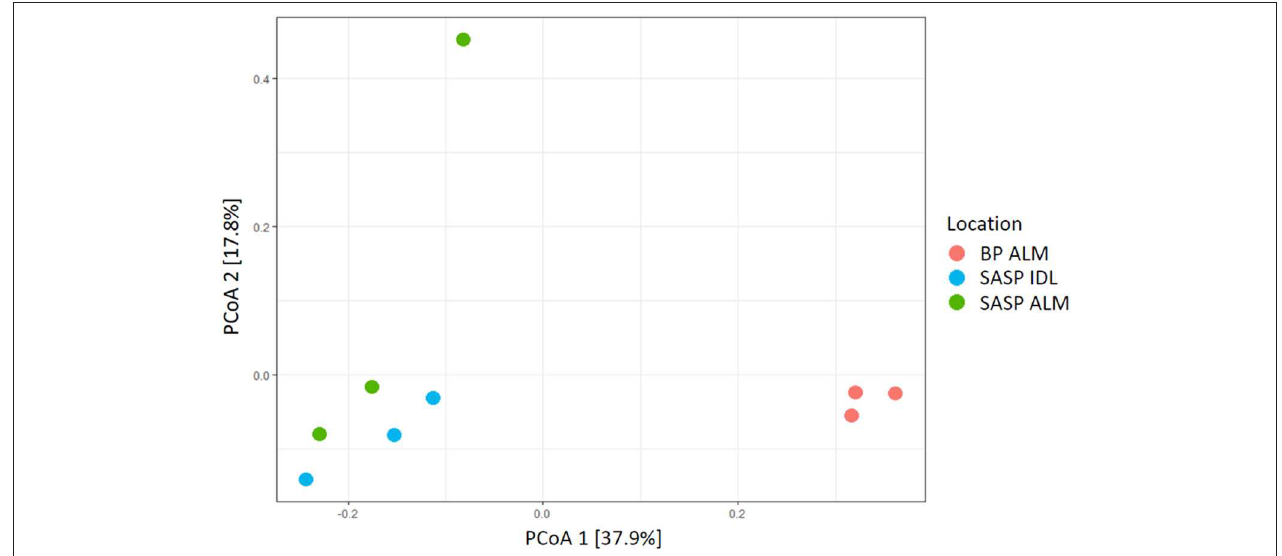
FIGURE 10 | PCoA plot of microbial communities from three snow samples (Bray-Curtis distances). The first principal coordinate accounts for differences in microbial communities based on location. The Samples Swamp Angel merged layer (SASP ALM) and Swamp Angel individual dust event layer (SASP IDL)–are more similar to one another than to the Berthoud Pass merged layer sample (BP ALM).